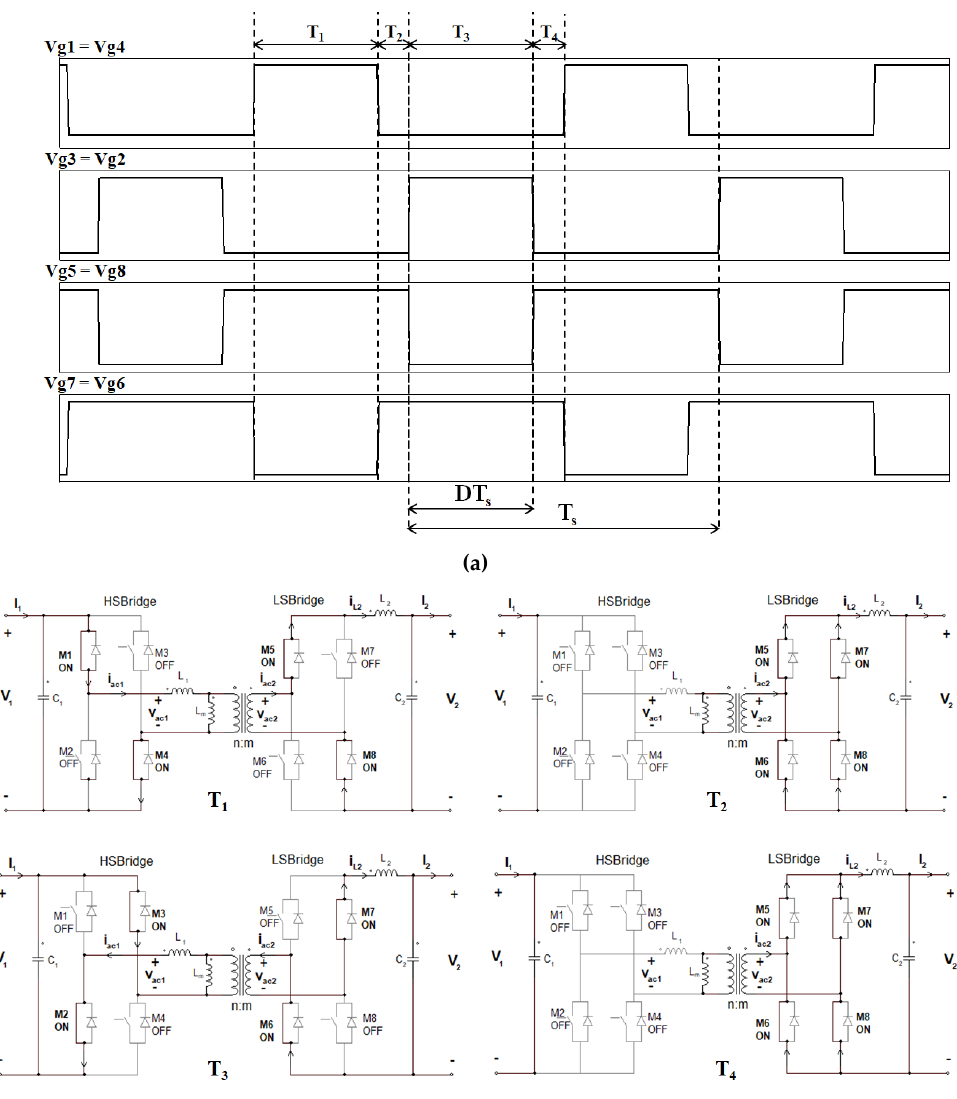
Figure 3. Pulse Width Modulation (PWM) case: ( a ) gate signals; ( b ) modes of operation.